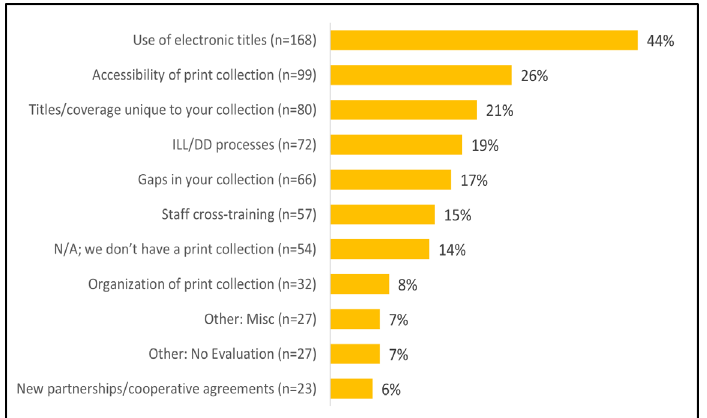
Figure 4 Percentage of Respondents (N=383) Evaluating Print Collection (705 responses).